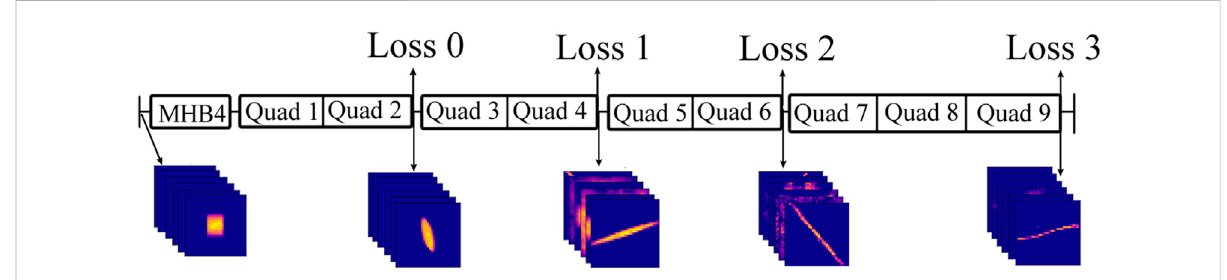
FIGURE 1 Cartoon of accelerator and beam measurements. The image shows where the model collected each beam